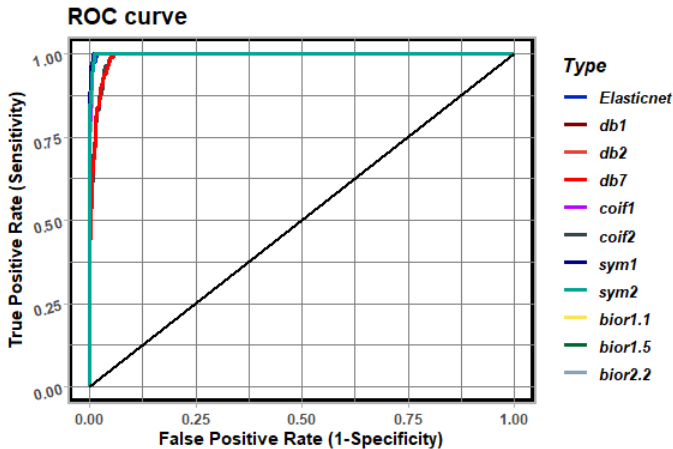
Figure 9. ROC analysis for example 2.